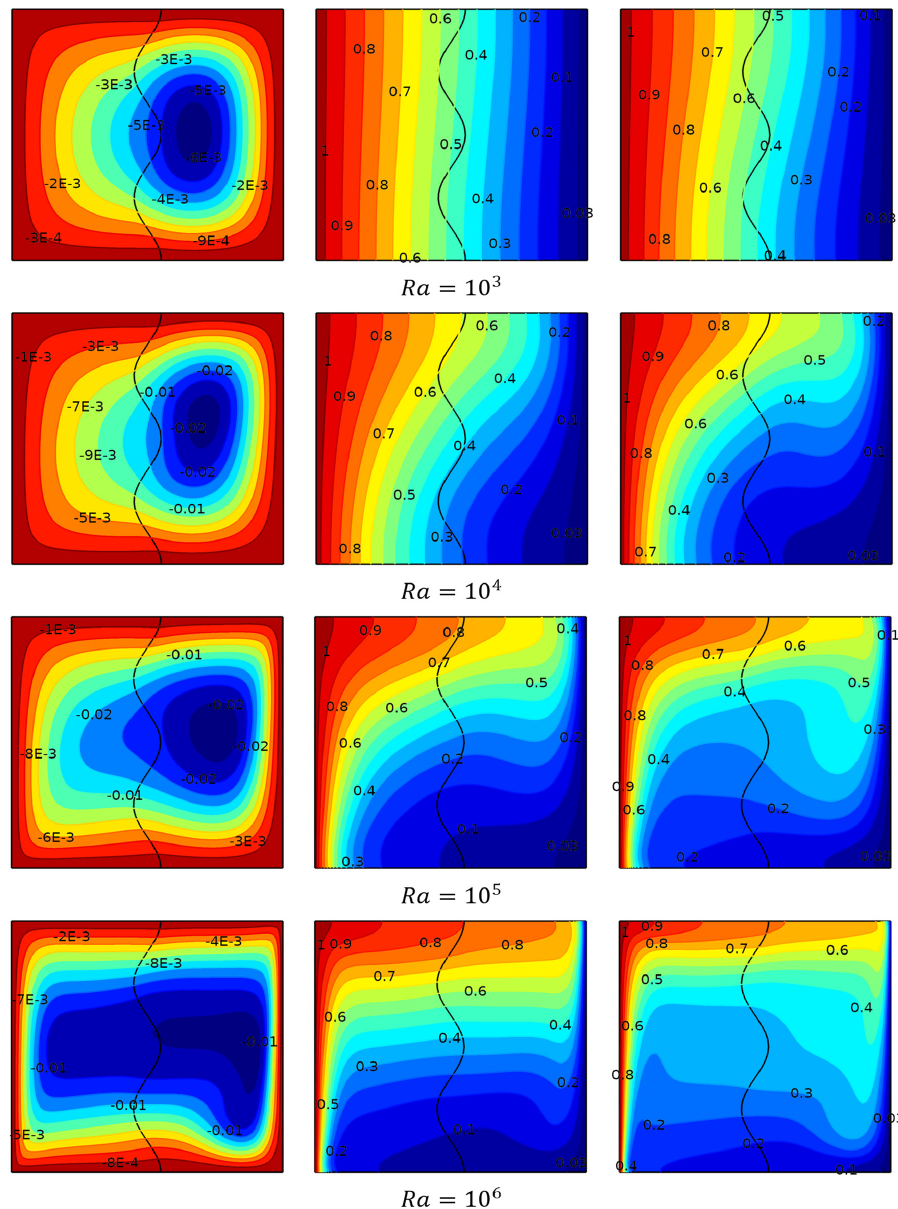
Figure 5. Streamlines (column 1), isotherms (column 2), and isoconcentration (column 3). As can be observed for Ra = 10 6 , the intensity of the streamlines occurs at the core of the cavity, indicating an increase in the heat transport, due to the natural convection. Here, it is noticed that the center of the vortex is still on the non-Newtonian side. By increasing the Ra number, the behavior of the isotherms is modified, due to the enhancement of the temperature gradient . When the Ra number is equal to 10 3 , the isotherms are parallel to each other, indicating the domination of the conductive heat transfer mode, but as its value rises, an increase in the temperature gradient is observed. The thermal flow passes